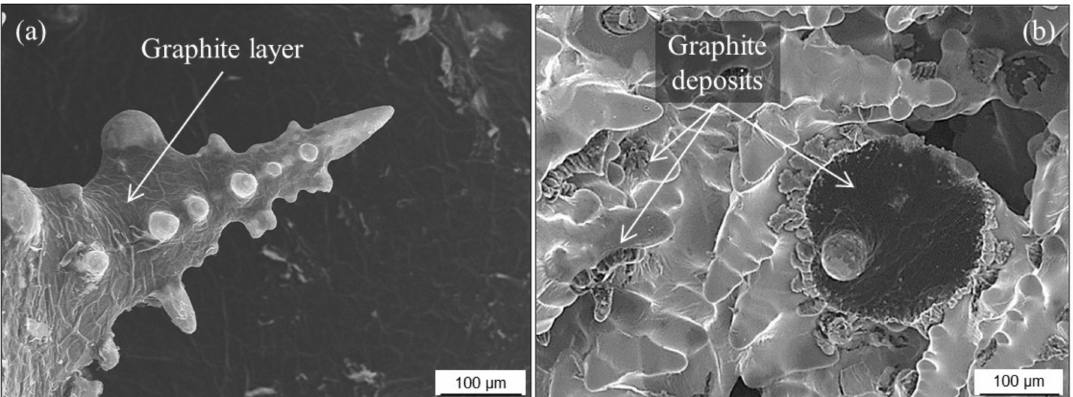
Figure 73. Characteristics in the internal surfaces of microshrinkage porosities found in the not- inoculated test castings ( a ) hypereutectic (Reprinted with permission from ref. [49]. Copyright 2017 Universitat de Barcelona) and ( b ) hypoeutectic